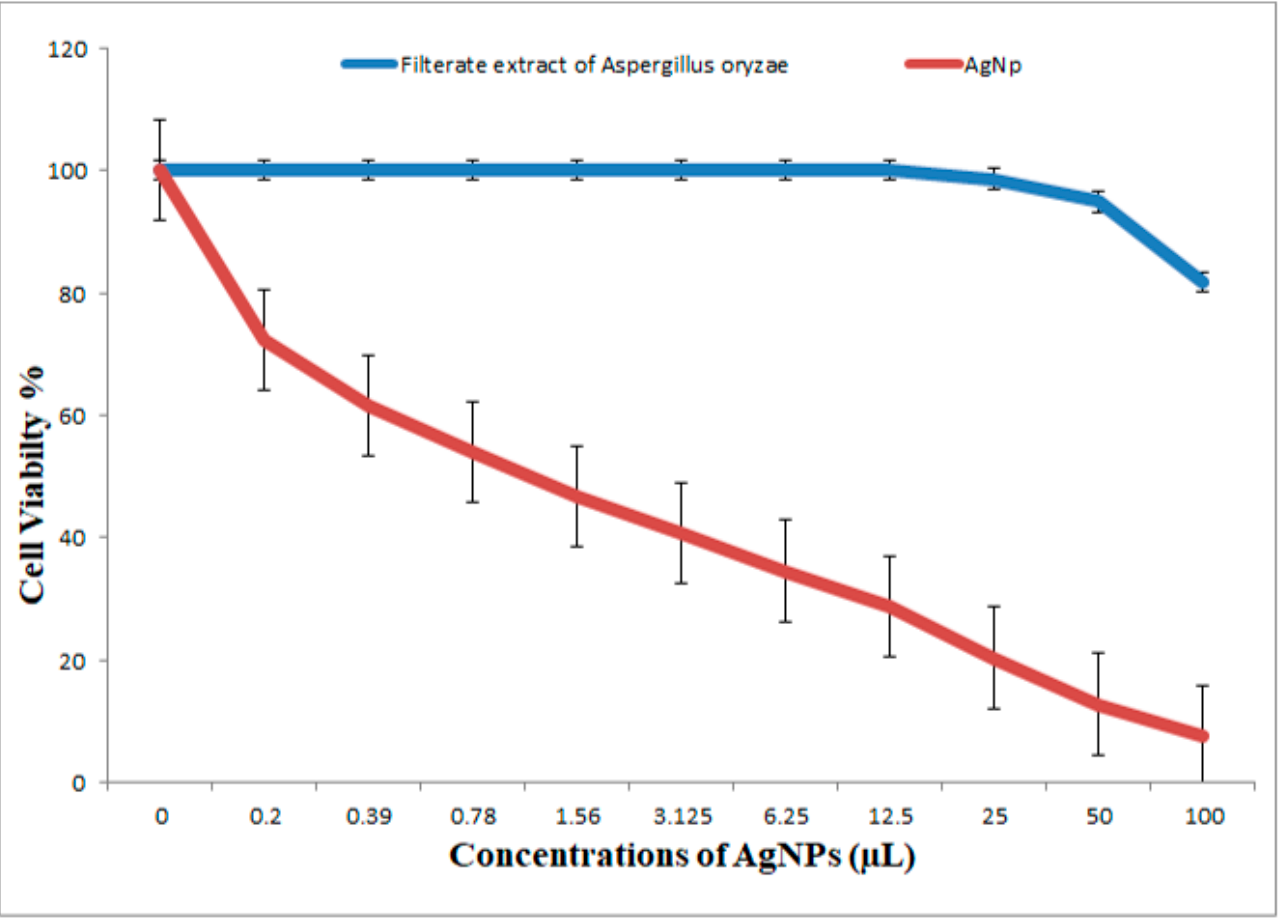
Figure 12. Viability of HCT-116 cells (colon carcinoma cell) (24 h incubation). Treatment with cell filtrate of Aspergillusoryzae as control and treatment with silver biosynthesized nanoparticles